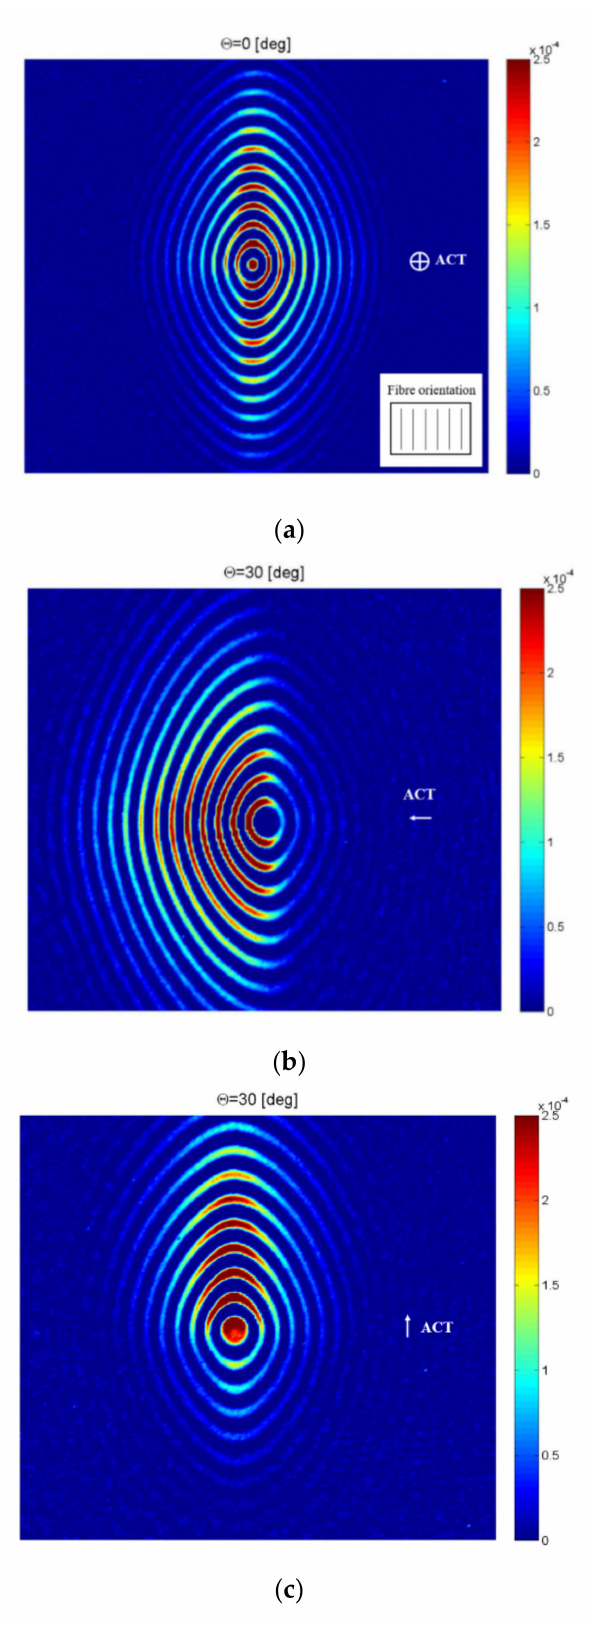
Figure 9. Selected frames from elastic waves propagation in the specimen for different ACT slope angles θ : ( a ) 0 ◦ , ( b ) 30 ◦ for waves generation across fibers, ( c ) 30 ◦ for waves generation along